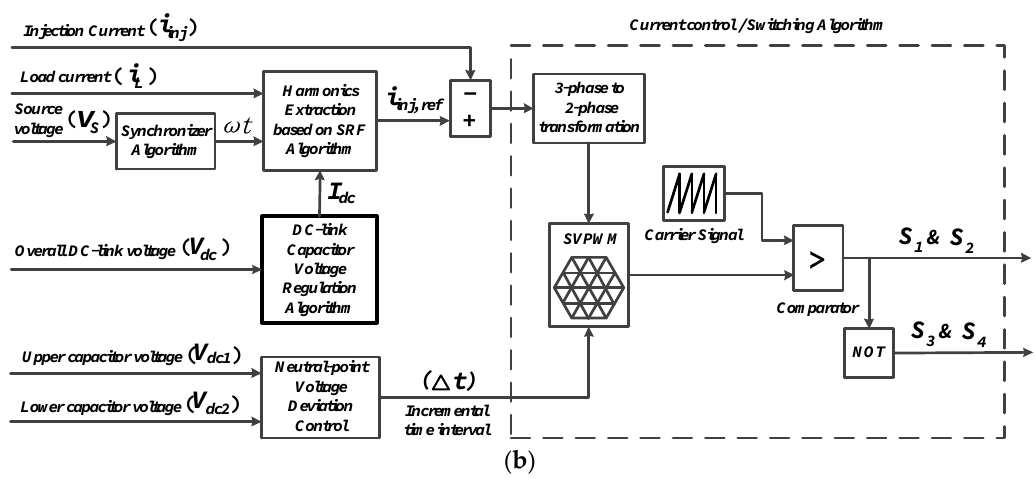
Figure 1. The proposed three-phase three-level NPC inverter-based SAPF: ( a ) circuit diagram, and ( b ) control strategies.